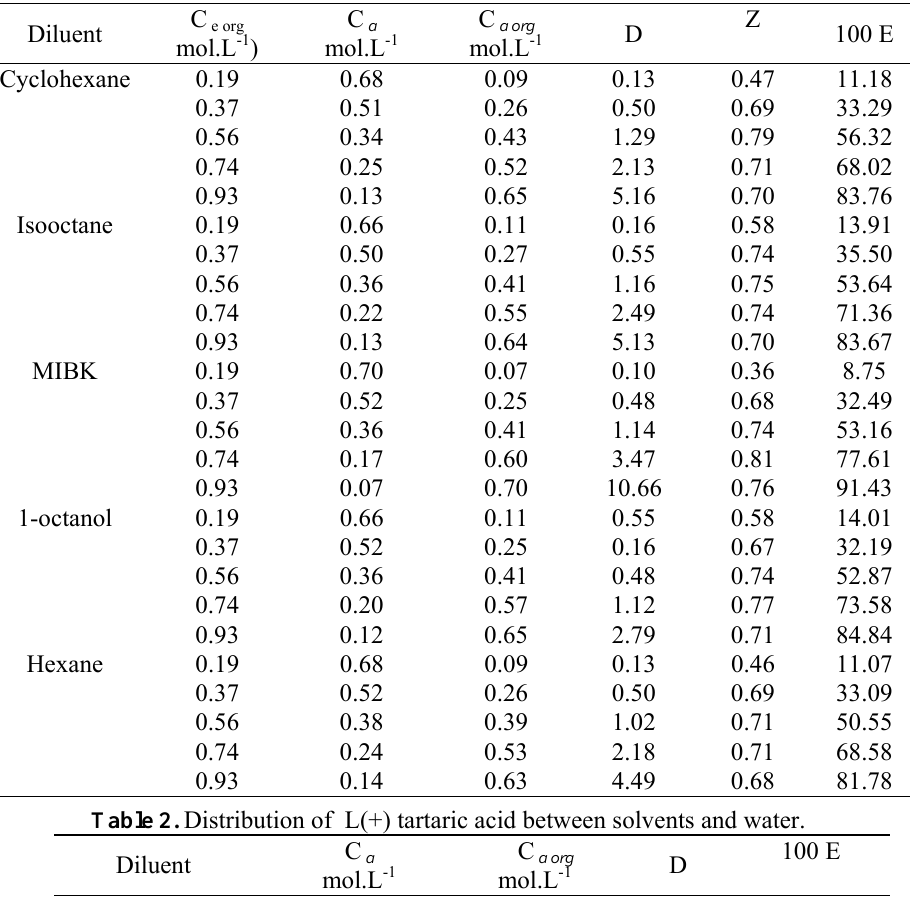
Table 1. Experimental results of the extraction of L(+) tartaric acid with amberlite LA-2 / individual diluting solvents.